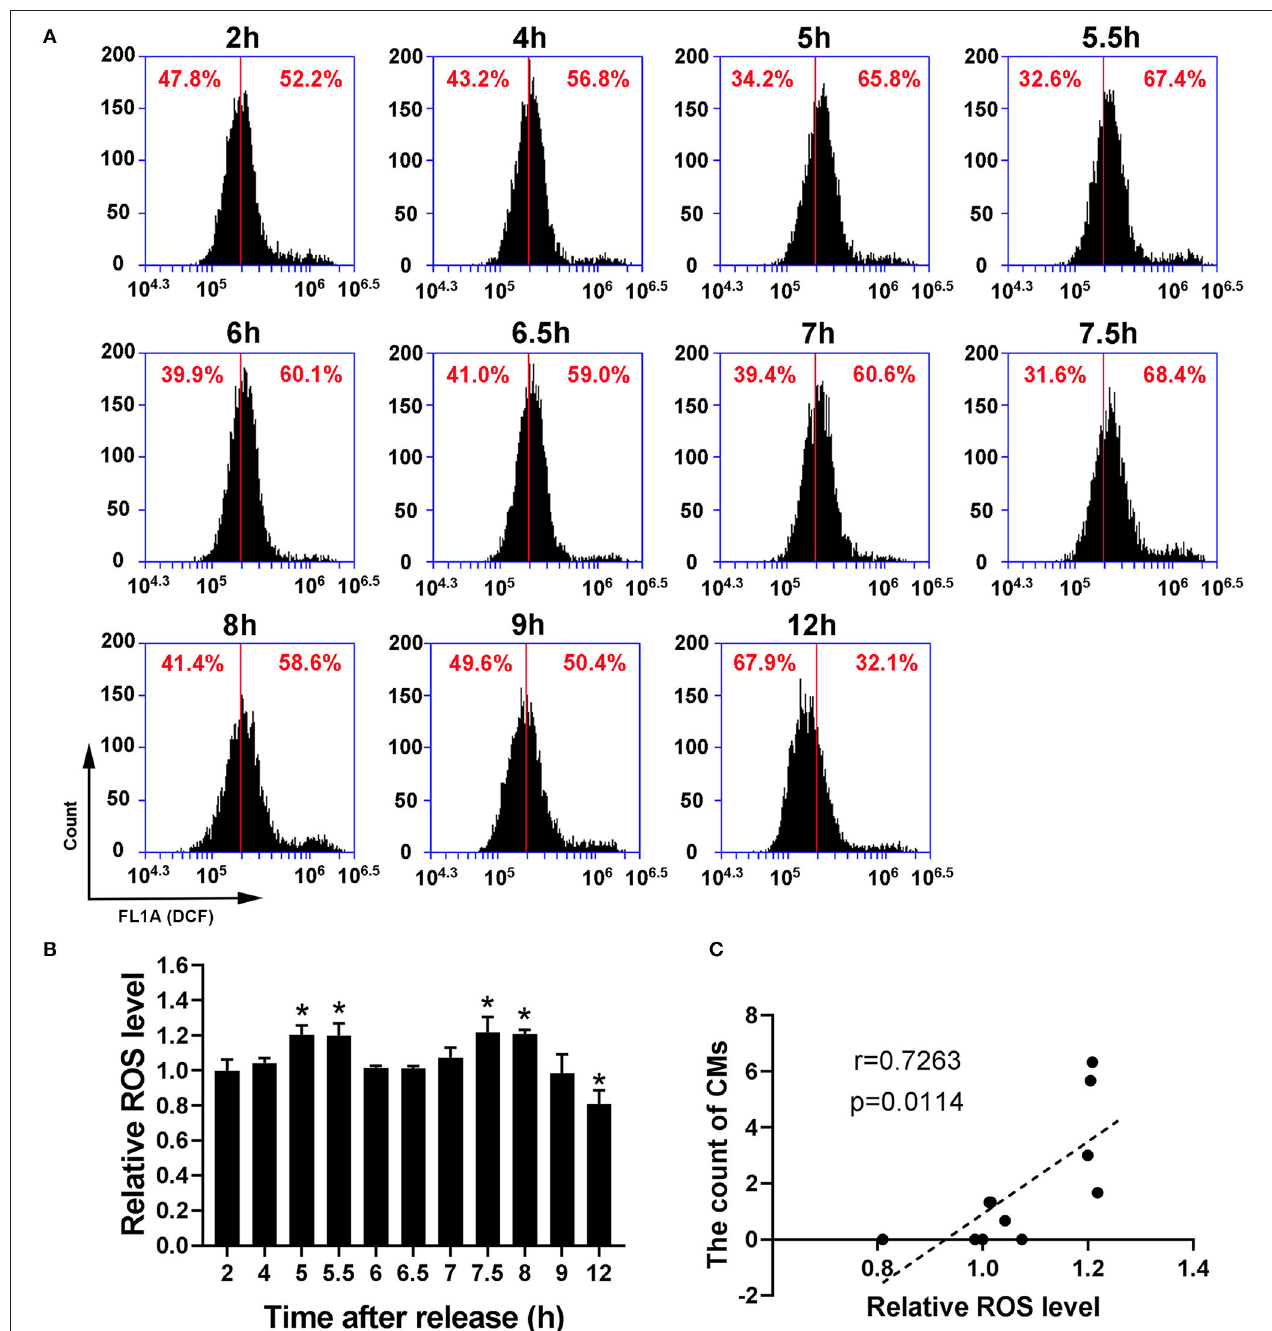
FIGURE 4 | The occurrence of CMs in G2 phase was correlated with ROS level. (A) Representative charts showing the change of ROS peaks after releasing from S phase which were detected by flow cytometry. The middle line was as a reference. (B) The histogram represented the change of ROS levels at indicated time points by analysis of fluorescence intensity. All values were denoted as the means ± SD; N = 3. * P ≤ 0.05, compared to the 2h group. (C) The correlation between the average count of CMs and relative ROS level was shown by Pearson’s correlation